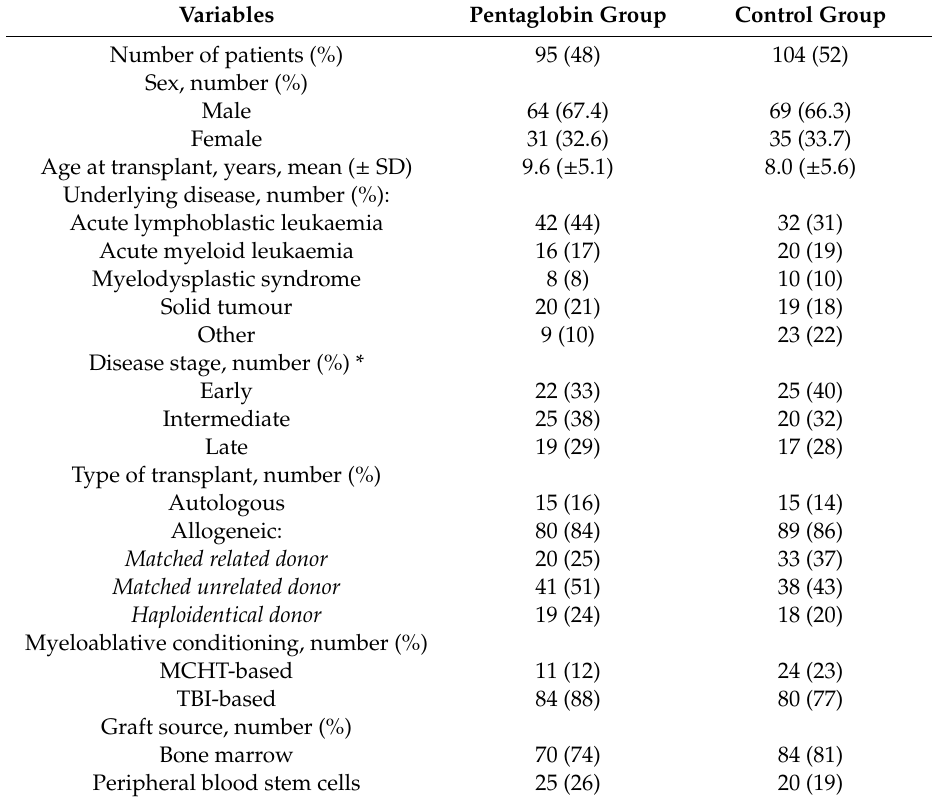
Table 1. Patient demographics, clinical, and HSCT features.